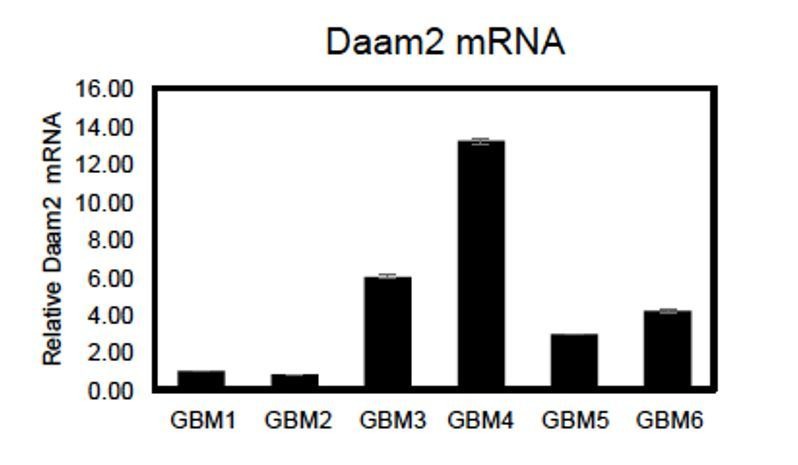
qRT-PCR showing relative expression of Daam2 across 6 primary GBM cell lines.